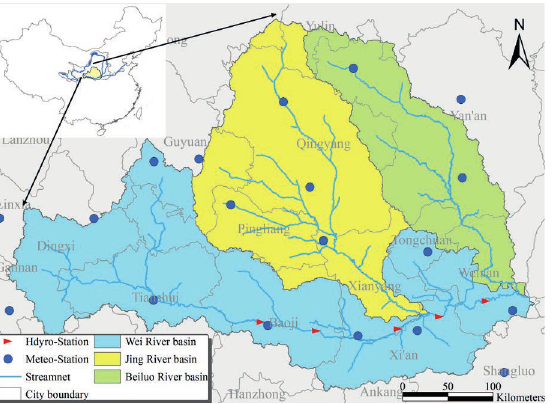
Fig. 1 Location of the WRB, and meteorological and hydrological stations used in this